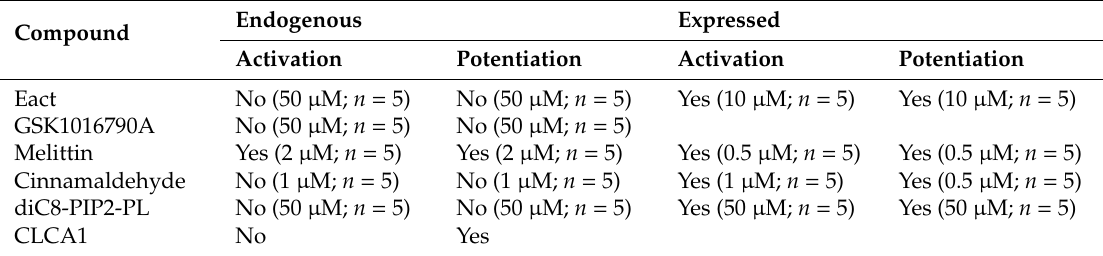
Table 1. E ff ects of potential activators / potentiators of TMEM16A in HT29 cells (endogenous TMEM16A) and HEK293 cells (overexpressed